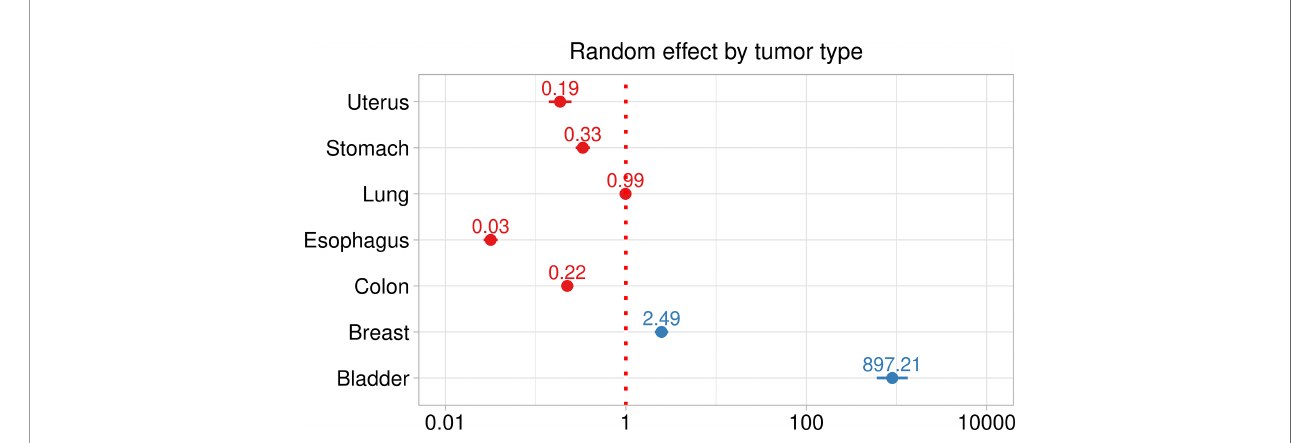
FIGURE 3 | Random effect plot of the mixed logistic model assessing the association between opioid receptors expression and type of tissue. Red dotted line, signi fi cance threshold. Dots effect estimates and bar 95% Con fi dence intervals.